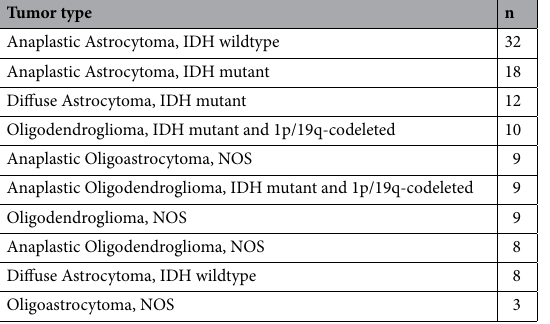
Table 1. Stratification of diffuse and anaplastic gliomas in our cohort according to the revised 4th WHO classification of the tumors of central nervous system from 2016.